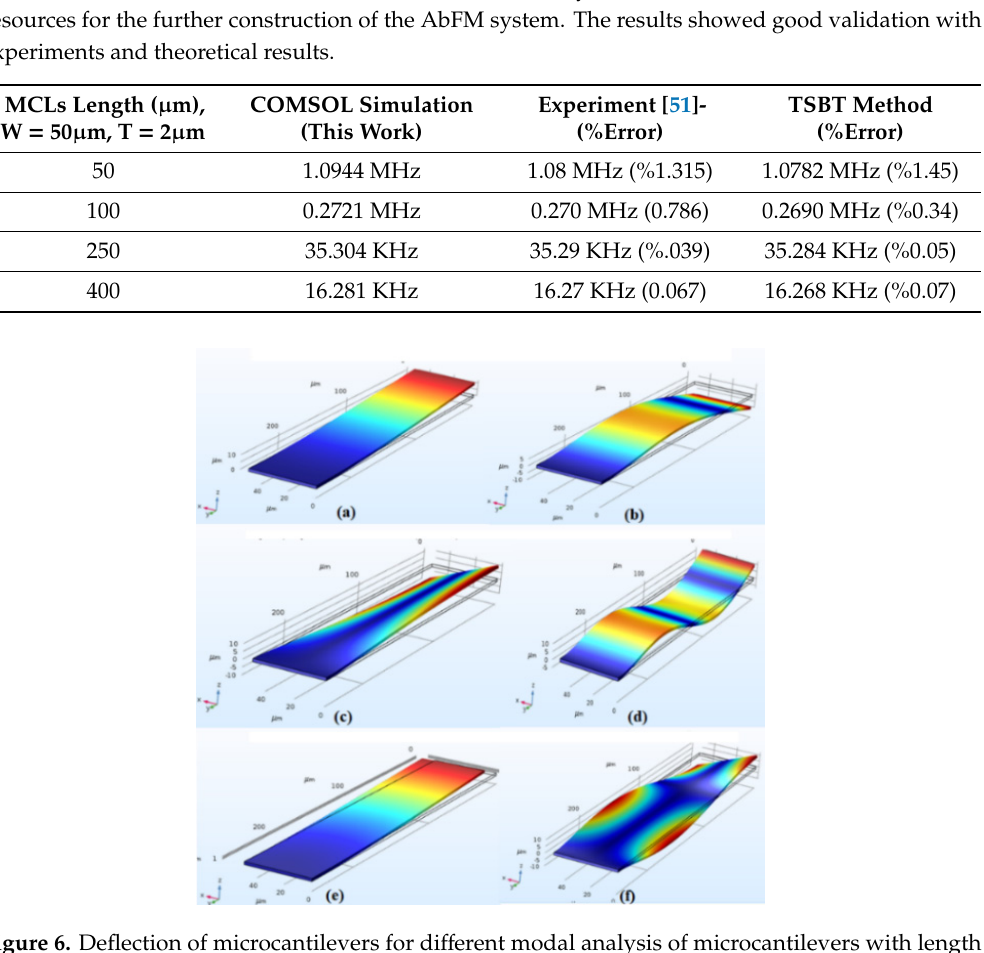
Table 2. The first mode of microcantilevers vibration calculated with COMSOL, TBT method and